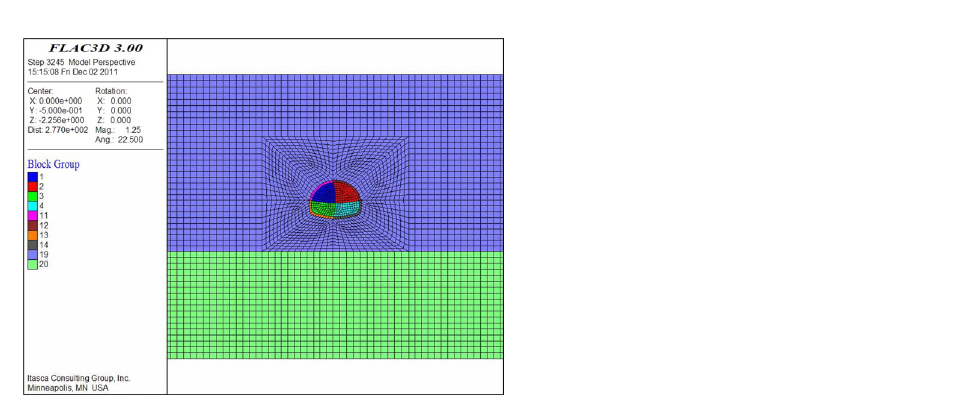
Figure 10. Double-sided pit method (FLAC3D 3.0 http:// docs. itasc acg. com/ flac3 d700/ flac3d/ docpr oject/ source/ flac3 dhome. html).